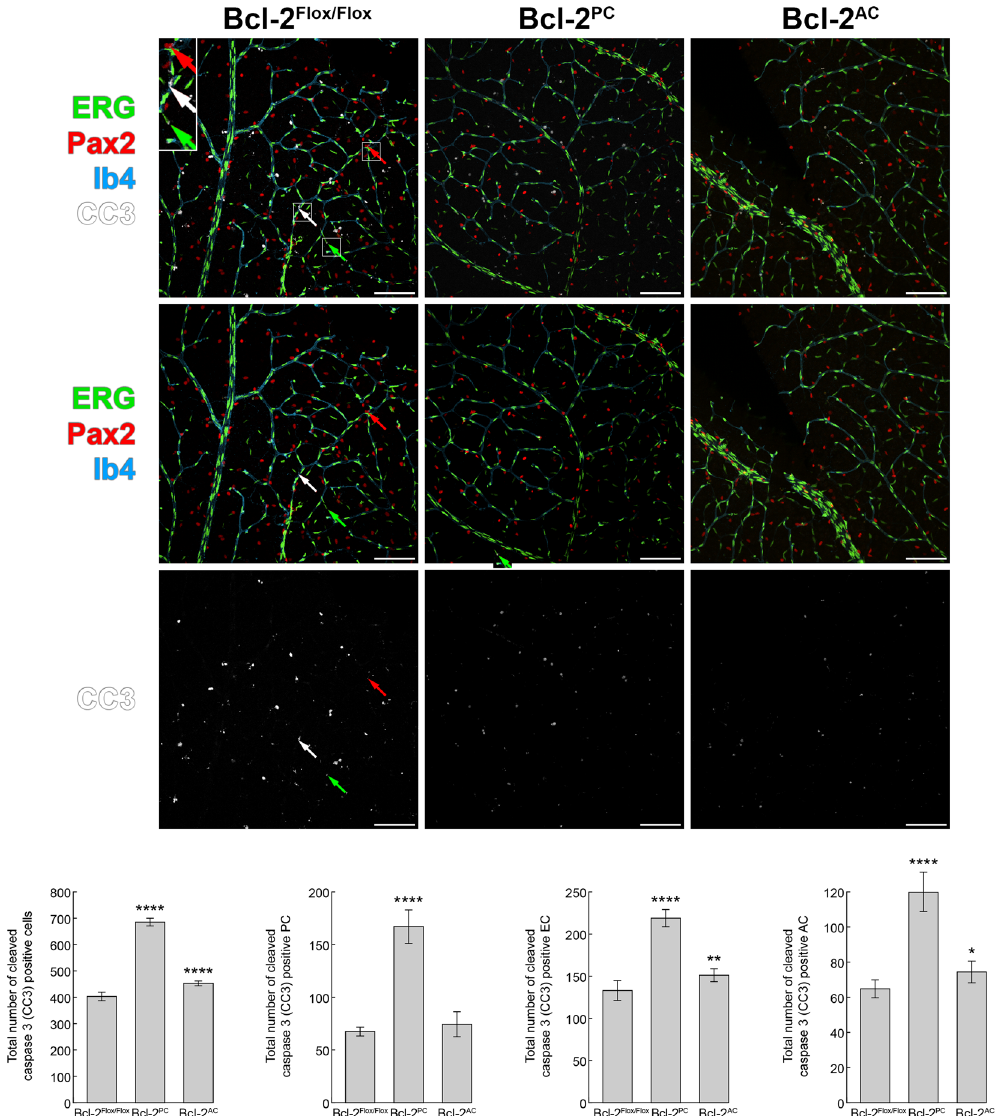
Figure 5. Increased apoptosis in retinas from Bcl-2 PC and Bcl-2 AC mice. Retinas from P14 Bcl-2 Flox/Flox , Bcl-2 PC and Bcl-2 AC mice were wholemount stained with anti-cleaved caspase 3 (white), anti-ERG (green), anti-Pax2 (red) and Isolectin-B4-FITC (blue). The cleaved caspase-3 positive cells associated with the vasculature were quantified throughout the entire retina that were anti-ERG positive (endothelial cells), anti-Pax-2 positive (astrocytes) or non-labeled (pericytes). Arrows point to apoptotic endothelial cell (green), astrocyte (red) and pericyte (white). The inset is a 200% magnification of the boxed areas of interest. Scale bar = 100 µ m. The mean number of cleaved caspase 3 positive endothelial cells, pericytes and astrocytes associated with the vasculature of each retina is denoted in the bar graph. Please note macrophages distinguished by their intense staining and large size, were not counted in the total number of capase 3 positive cells (n = 6, *** P < 0.001, **** P <